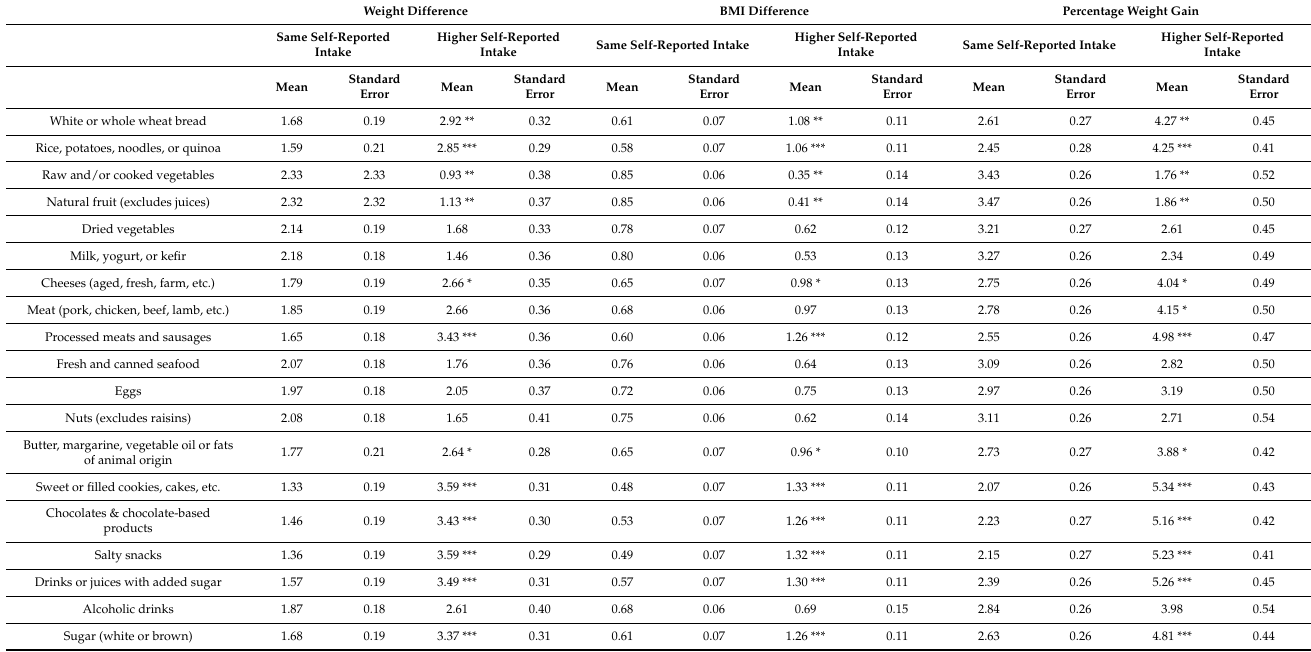
Table 2. Comparison of the difference in weight, BMI, and percentage weight before and during lockdown between subjects with the same self-reported intake or higher self-reported intake by food